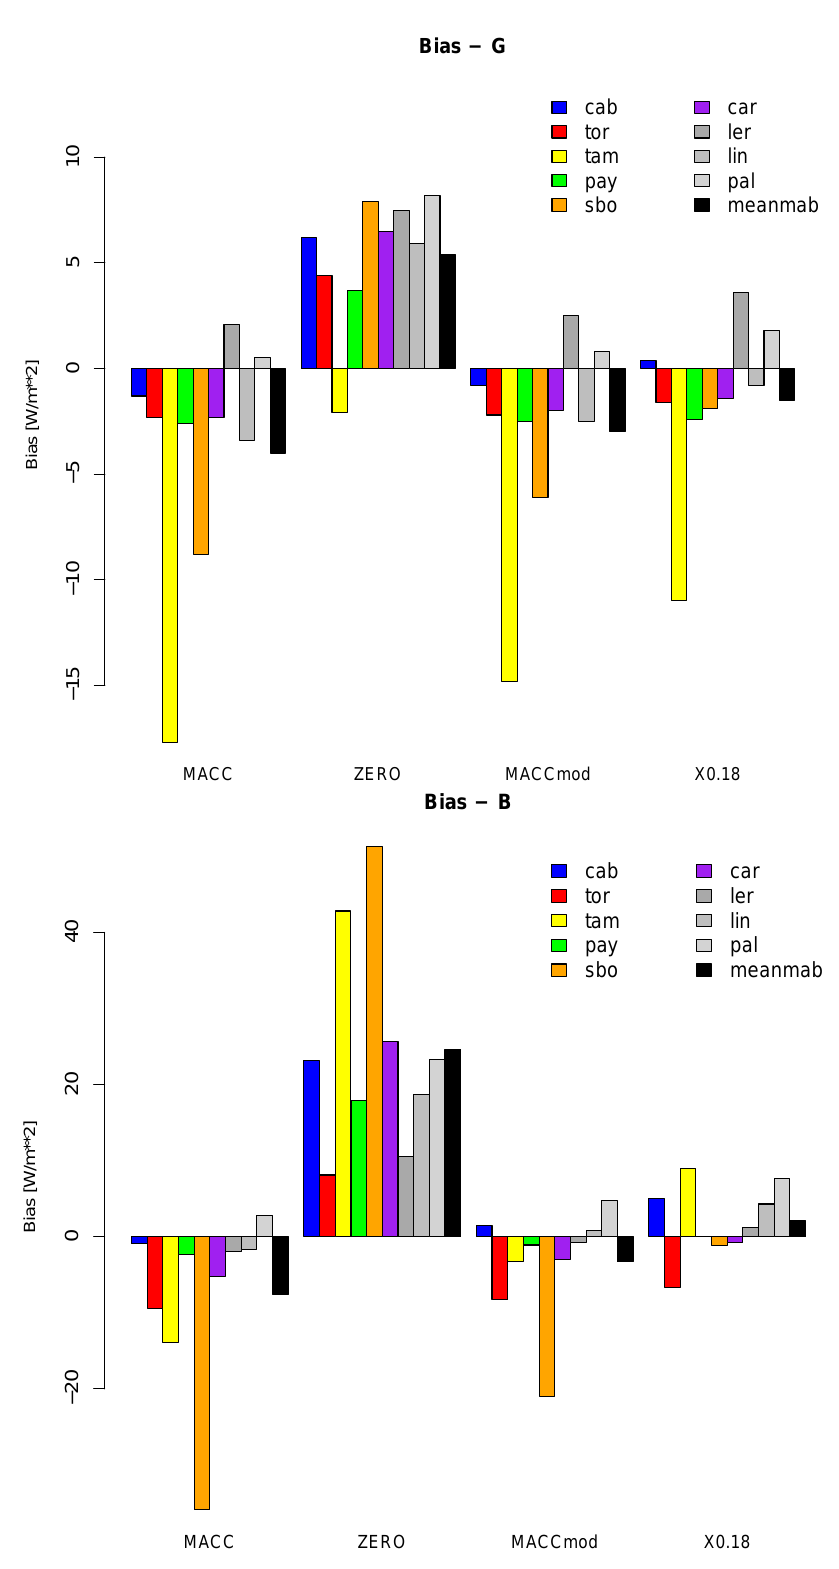
Figure 6. Bias for the global irradiance (Bias-G, top ) and direct irradiance (Bias-B, bottom